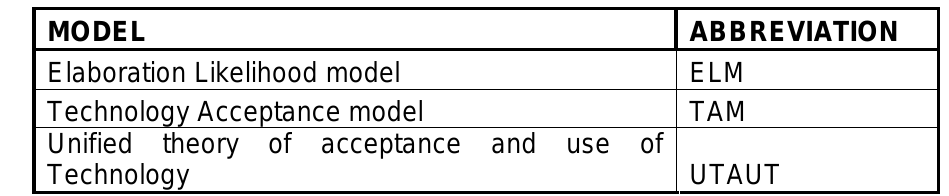
Table 1: List of IT acceptance models MODEL ABBREVIATION Elaboration Likelihood model ELM Technology Acceptance model TAM Unified theory of acceptance and use of Technology UTAUT Elaboration likelihood